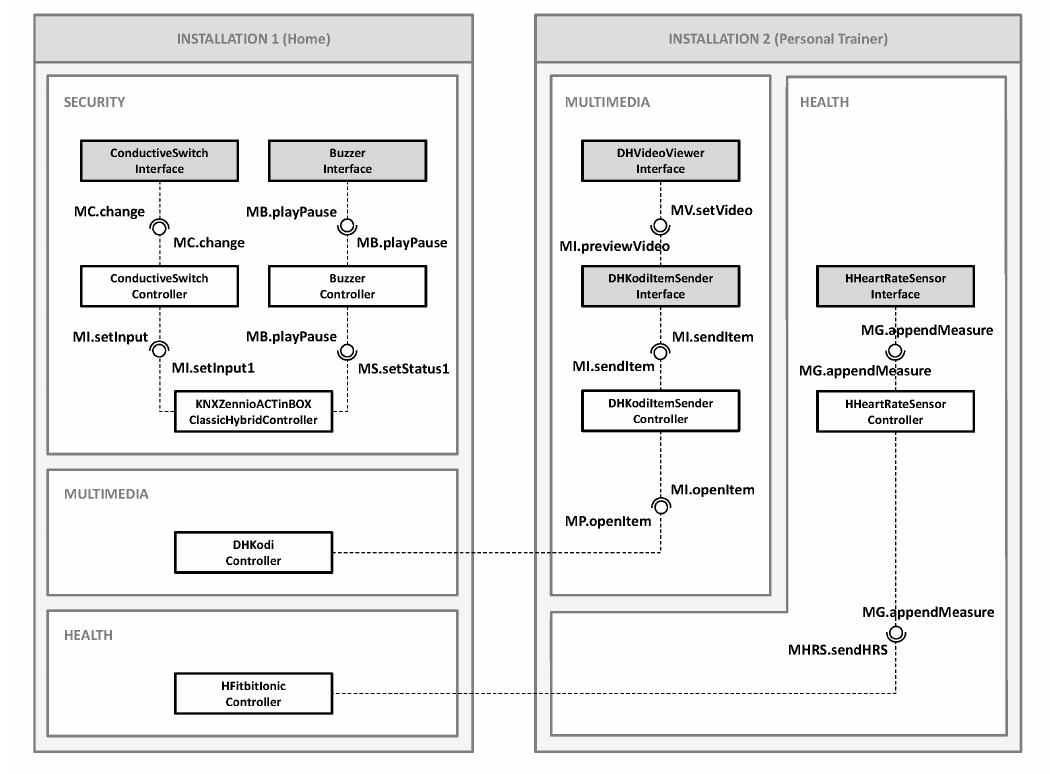
Figure 6. Partial representation of the example